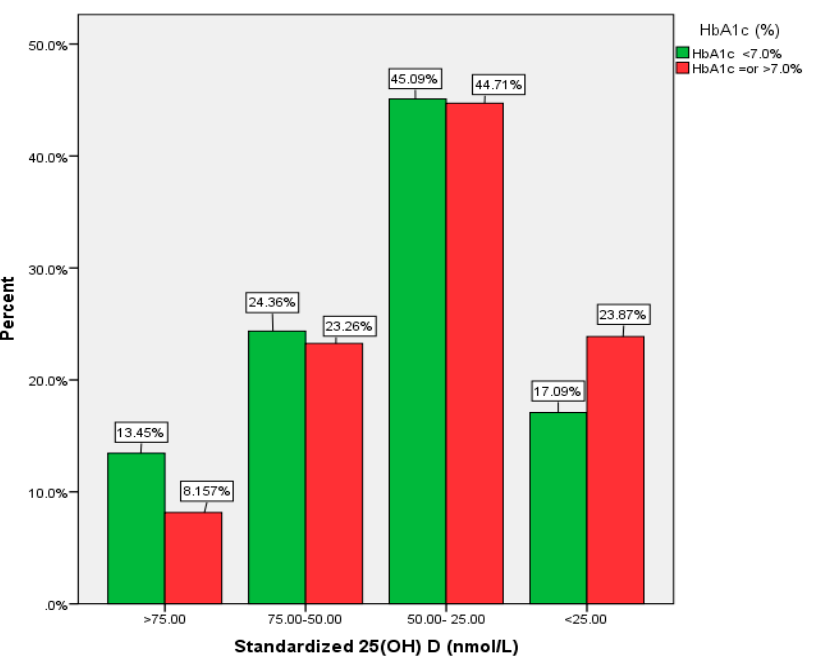
Figure 1. Proportion of diabetic patients with HbA1c < 7.0 and > 7.0% by vitamin D categories in Riyadh, Saudi Arabia.